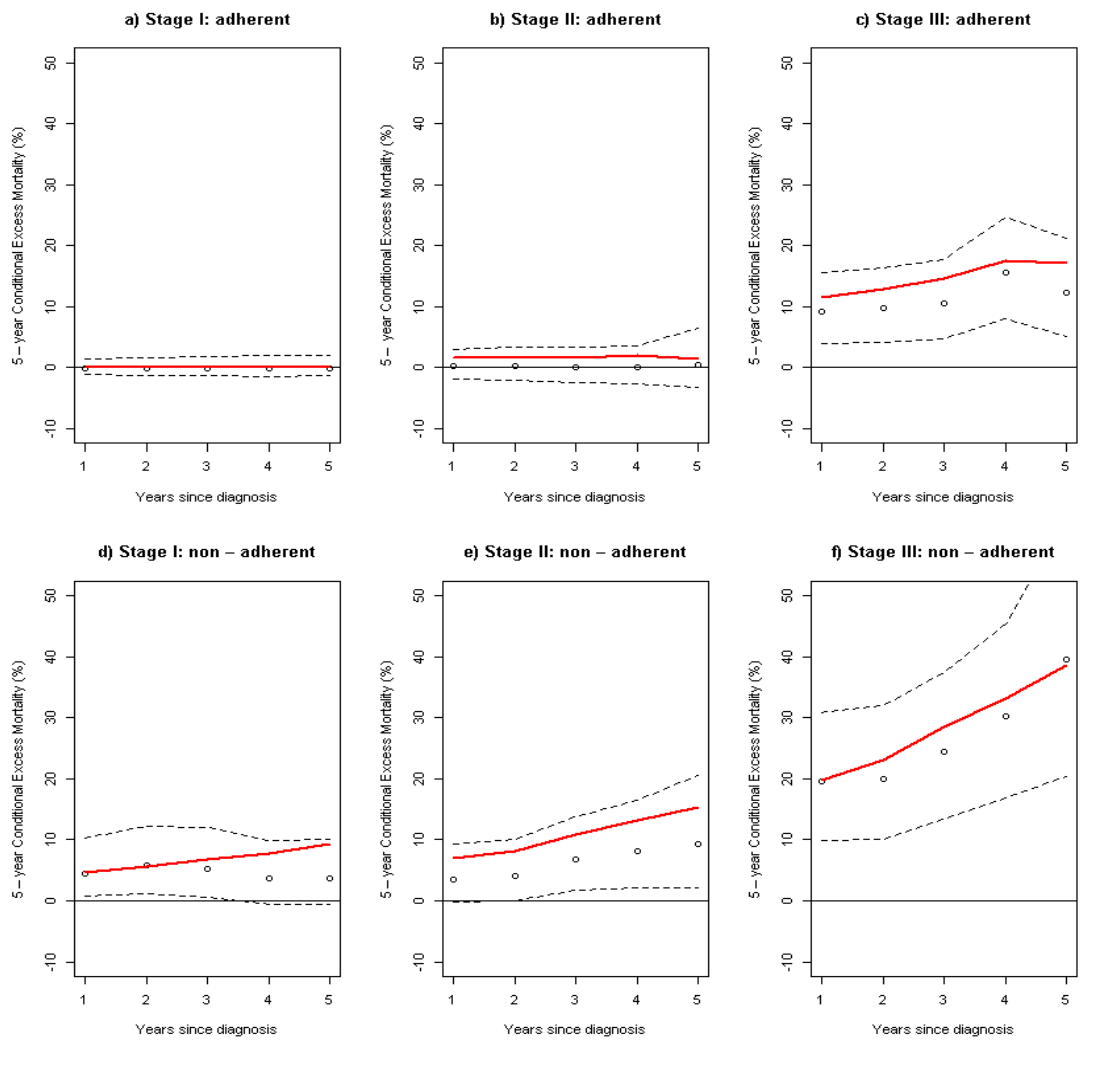
Figure 4. Comparison of 5-year conditional excess mortality (in percentage) between original cohort (black) and combined cohort (red) across stage at diagnosis and stratifying by adherence to endocrine therapy: ( a , d ) Stage I; ( b , e ) Stage II; ( c , f ) Stage III.